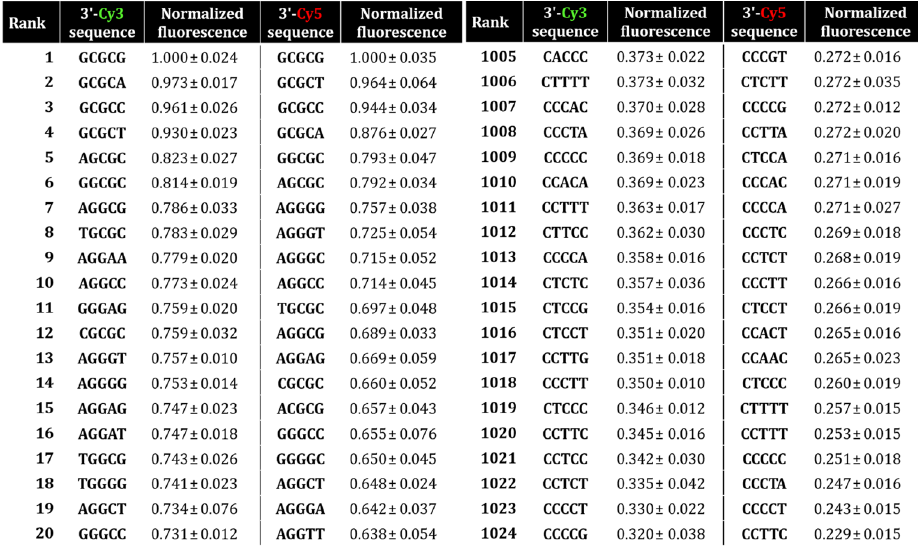
Table 1. Normalized relative fluorescence intensity of the 20 brightest and darkest pentamers 3 ʹ -Cy3 and Cy5 labeled. SEM is standard error of the mean.